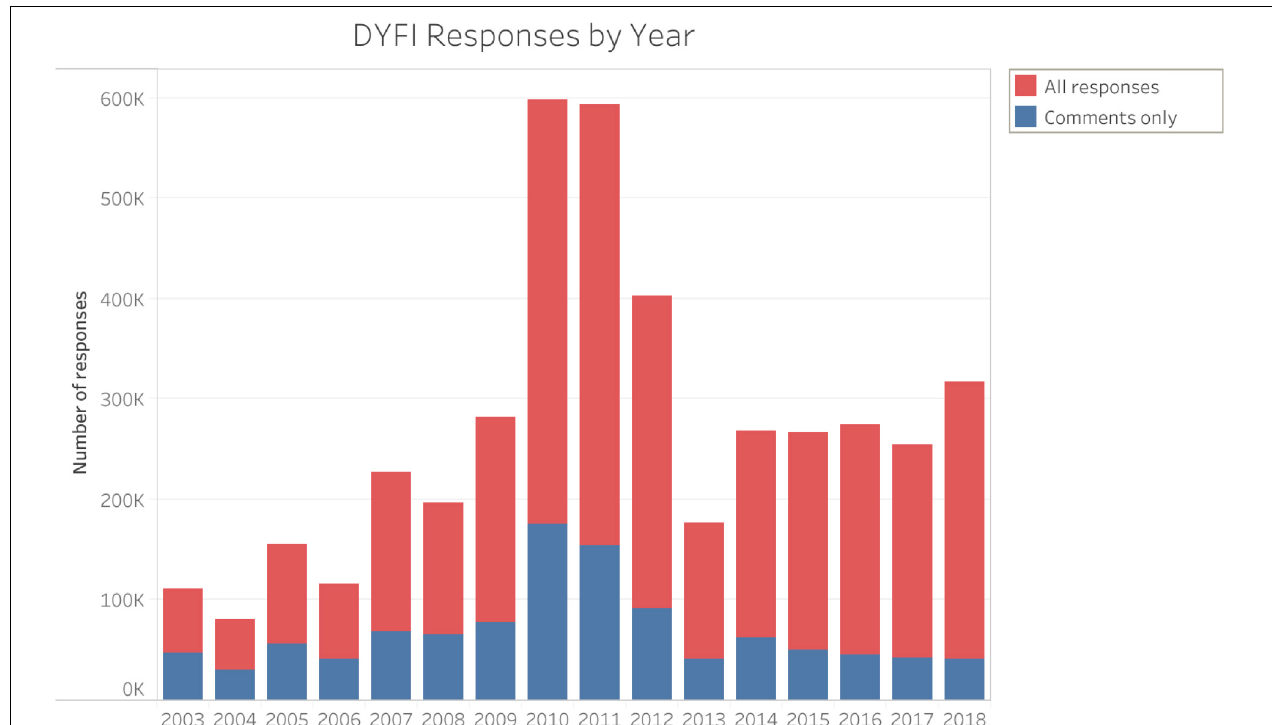
FIGURE 6 | Number of DYFI responses received from all countries each year. Red bars count all responses. Blue portions count only responses which also include